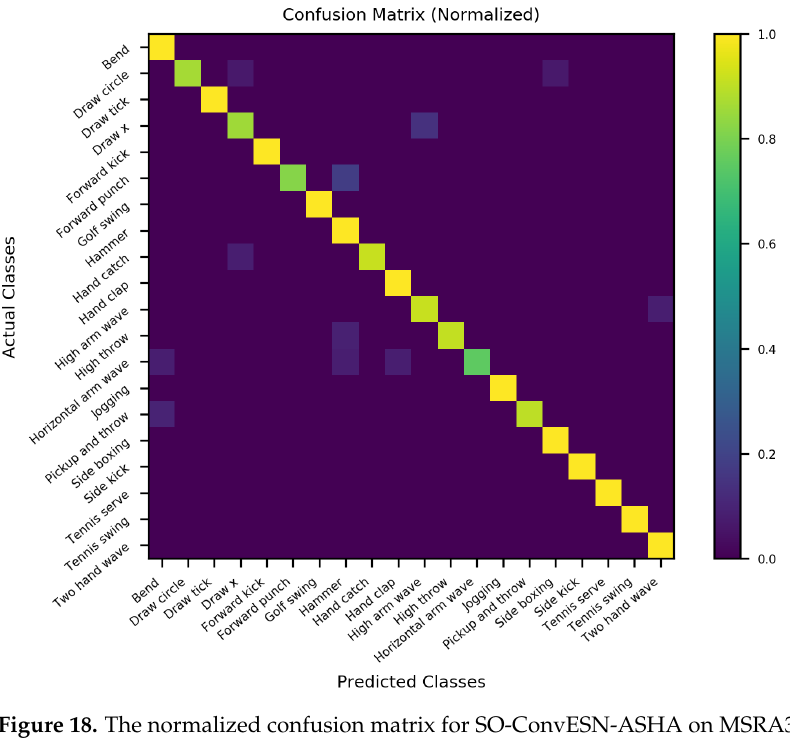
Figure 18. The normalized confusion matrix for SO-ConvESN-ASHA on MSRA3D dataset.